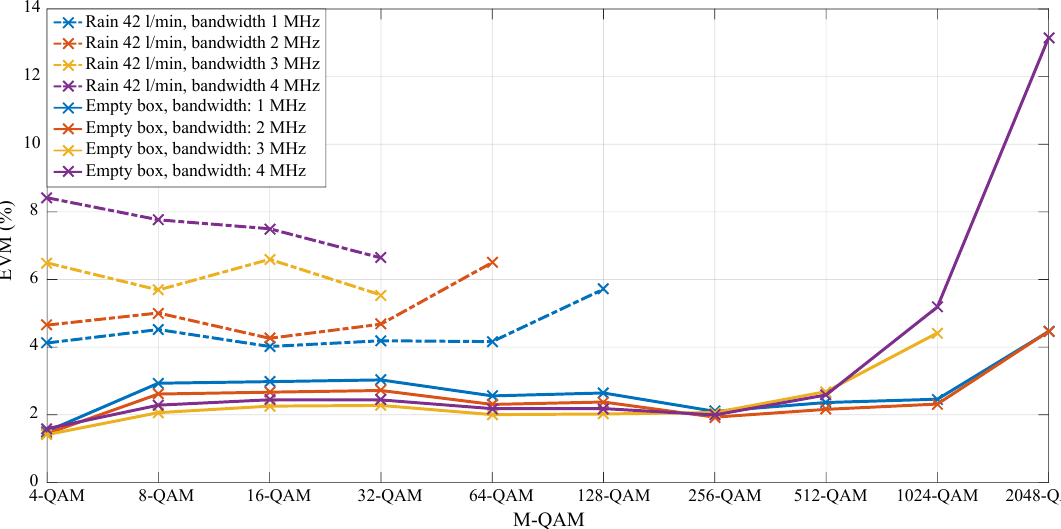
Figure 26. EVM/distance relationship for Octavia tail-light with different M-QAM and bandwidths —scenario 3—Rain 42